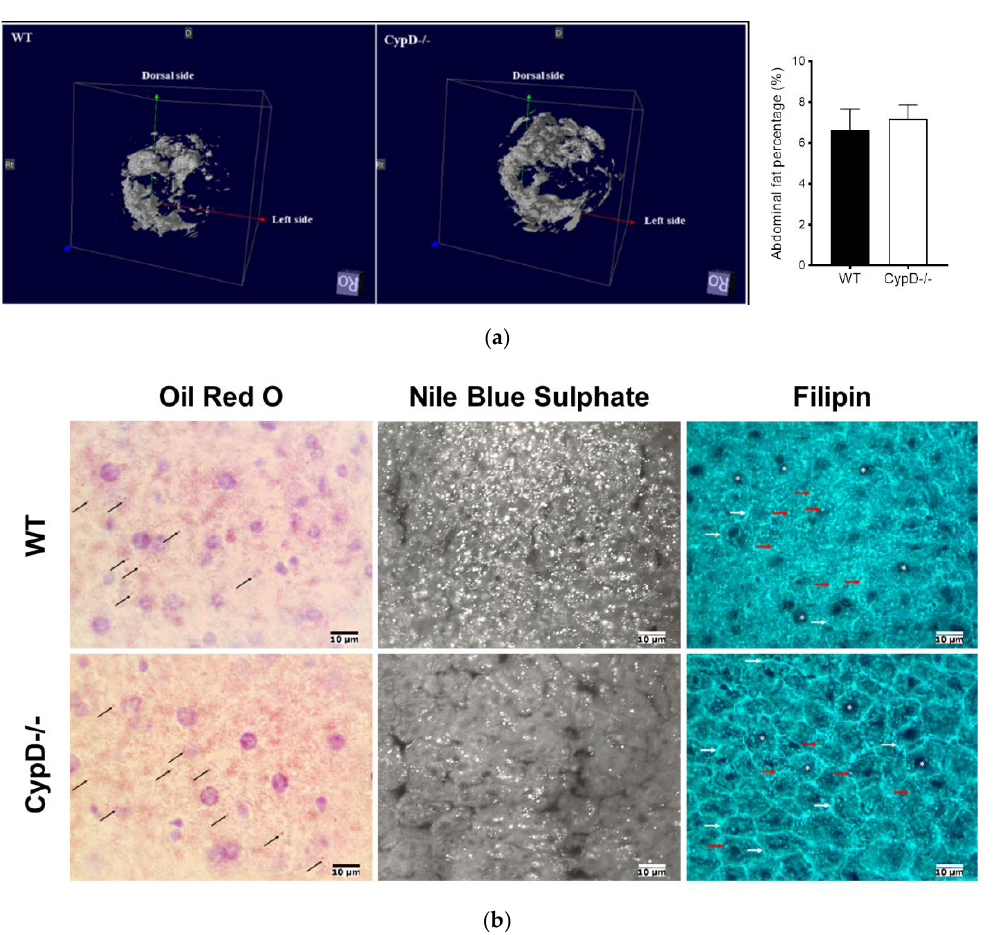
Figure 5. In vivo body fat measurements and histological analysis of liver lipid distribution in WT and CypD-/- mice. The in vivo abdominal fat distribution of WT and CypD-/- mice ( n = 6) were compared using MRI (T1 3D FLASH sequence with and without magnetization transfer calibrated to a water – fat phantom). ( a ) Representative images show the 3D distribution of abdominal fat (resolution: 120 × 120 × 2250 μm 3 ); bar chart shows the statistical analysis of body fat distribution between WT and CypD-/- animals. Data are shown as mean ± SEM, n = 10. ( b ) The occurrence and distribution pattern of neutral lipids (Oil Red O), phospholipids and fatty acids (Nile Blue Sulphate), and cholesterol (Filipin) in the liver cells of WT and CypD-/- animals. Arrows show lipid droplets, and asterisks label the cell nuclei.